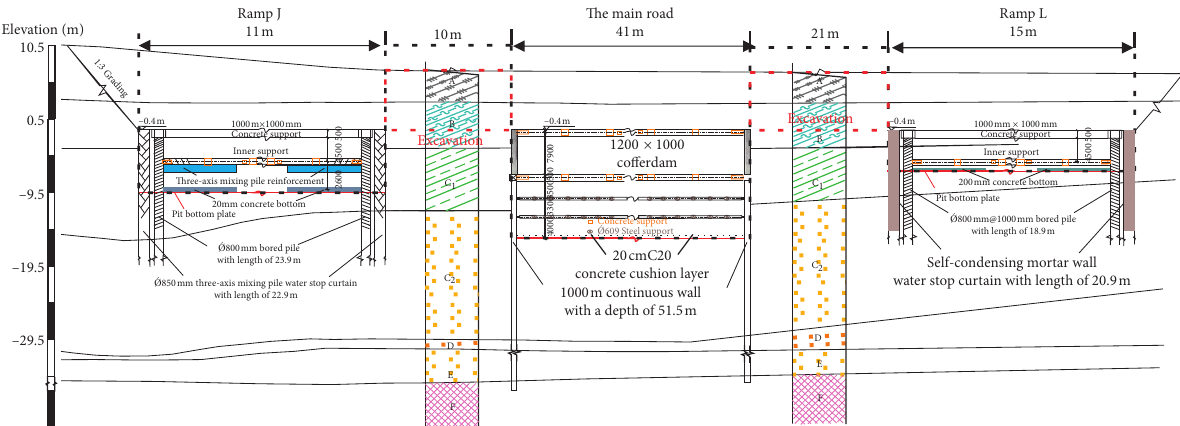
Figure 6: Schematic diagram of the supporting structure in the SE area.